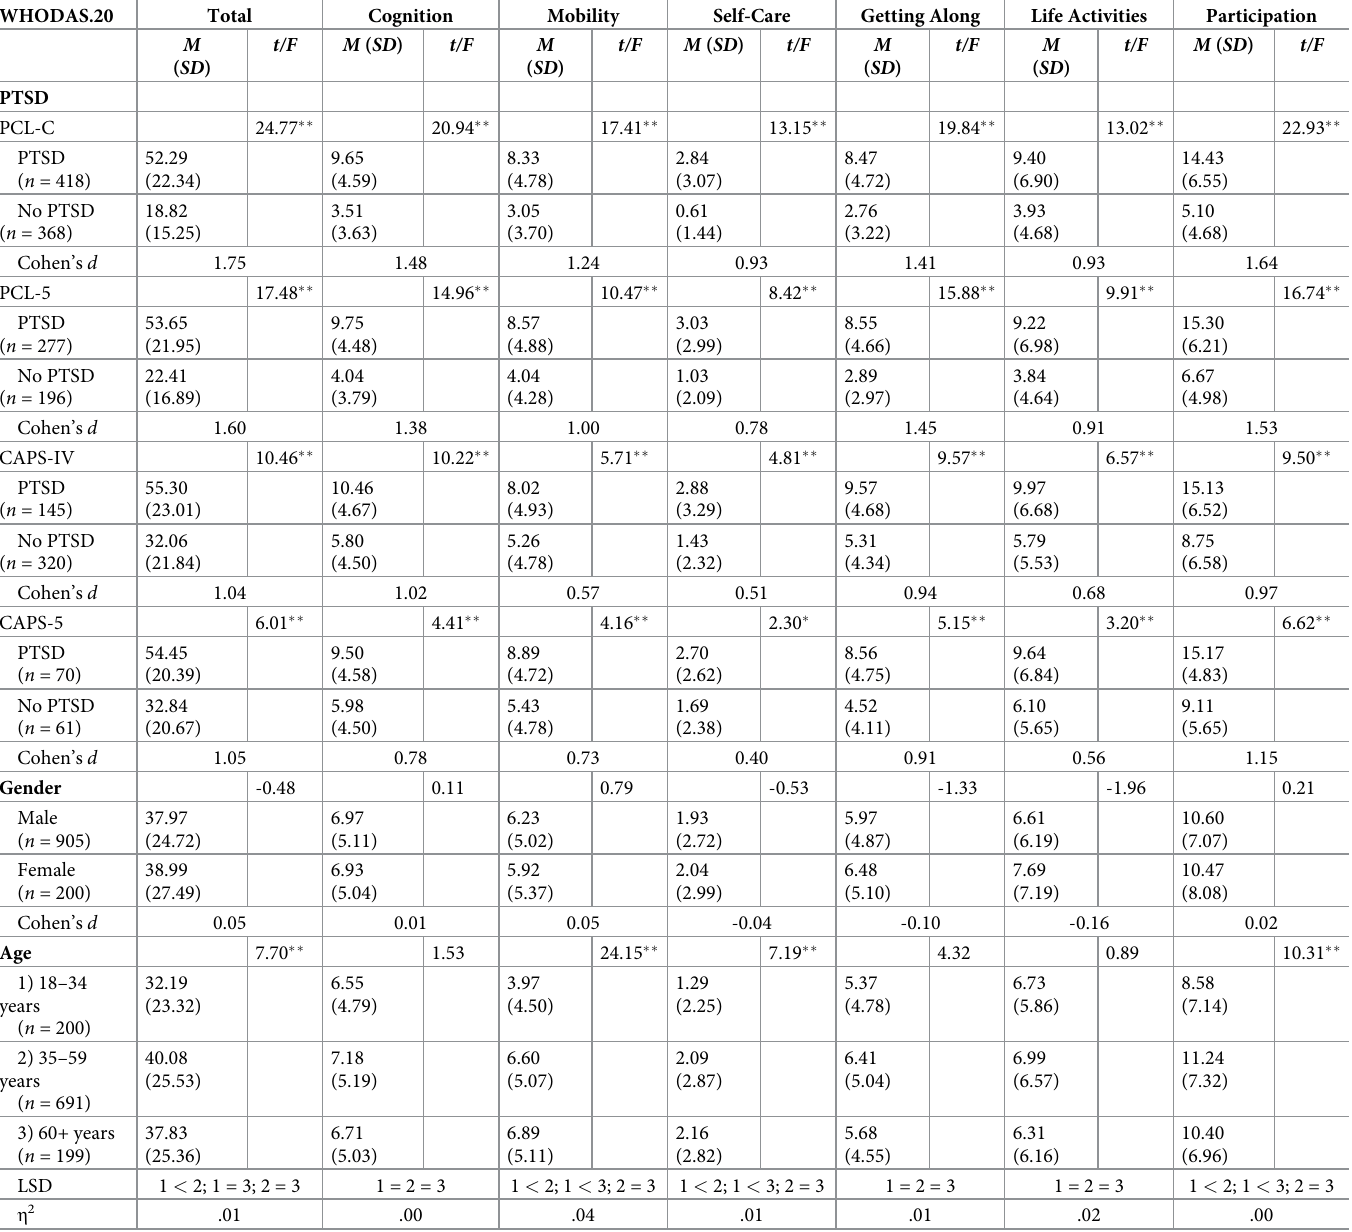
Table 2. Comparison of WHODAS means as a factor of PTSD diagnostic status, gender, and age a . WHODAS.20 Getting Along Life